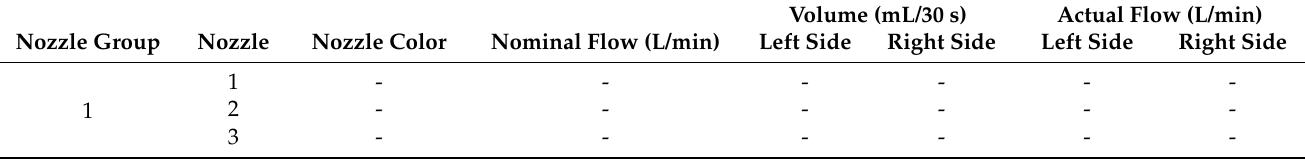
Table A1. Selection and calibration of nozzles for the T sprayer, with the following configuration: Adjusted to the vegetation/High & Low fan speed/Low spray volume rate/Conventional nozzles (Fine)/Pressure: 10